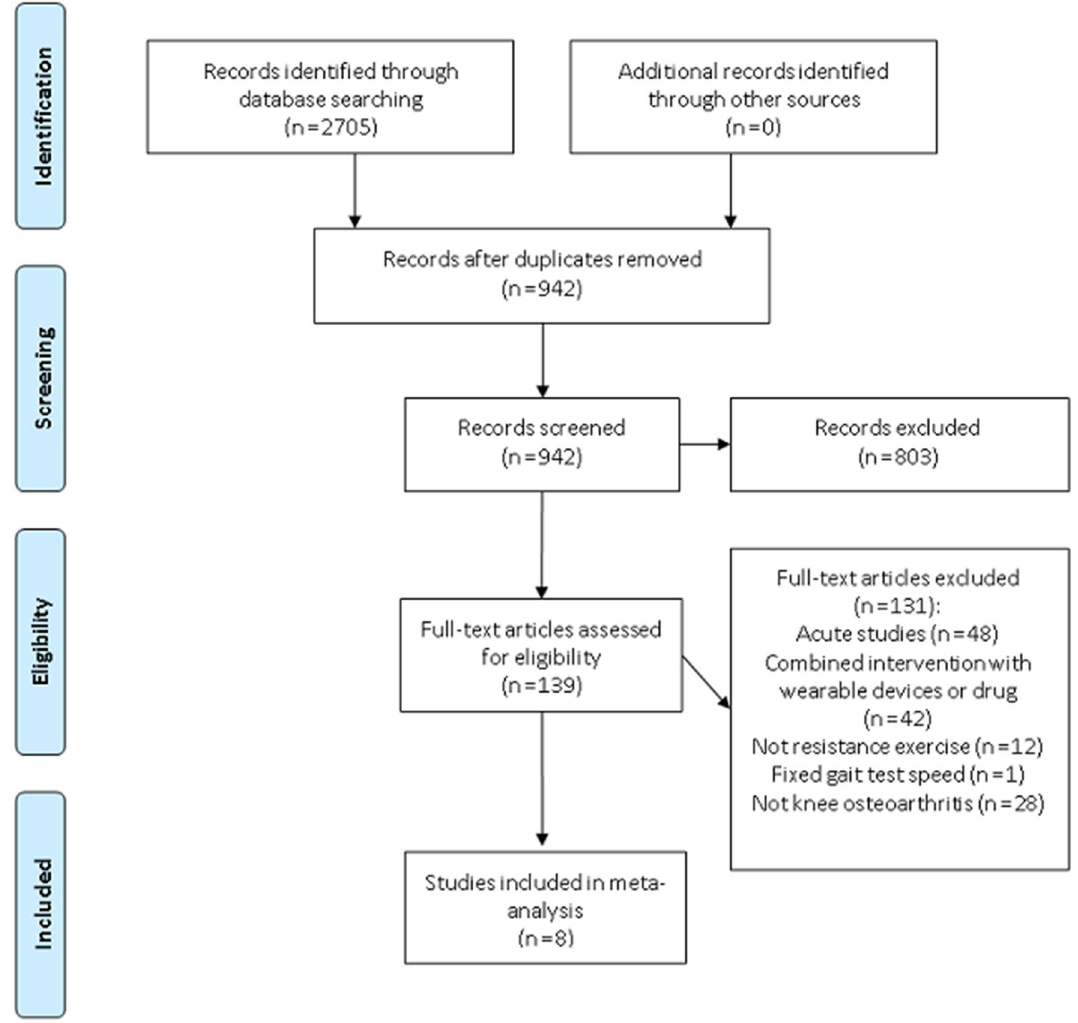
Figure 1. Flow diagram showing the process of identifying and selecting the relevant studies. PEDro